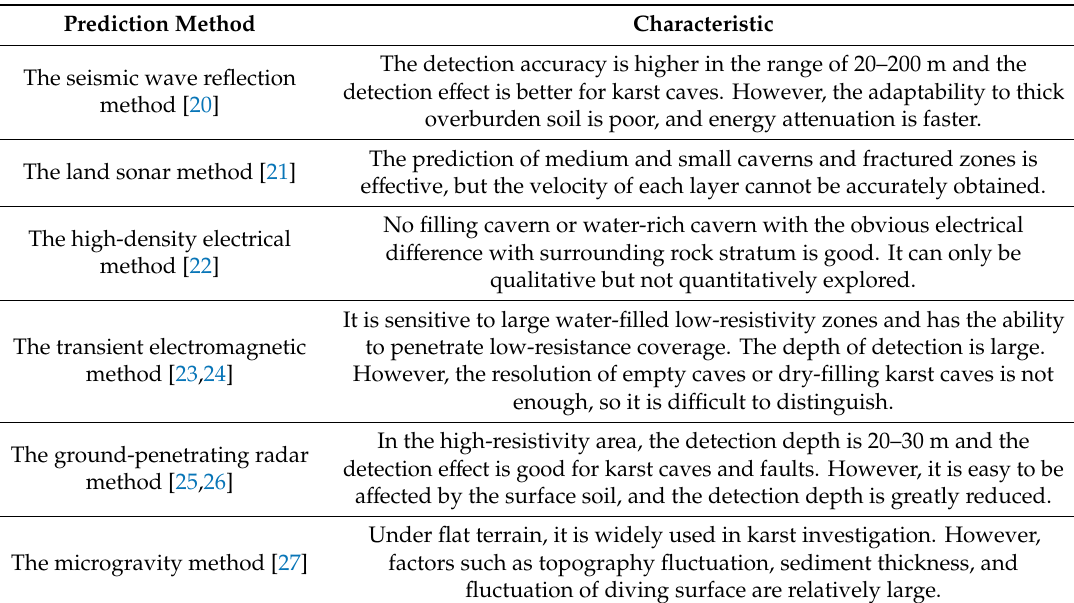
Table 1. The characteristics of di ff erent geophysical